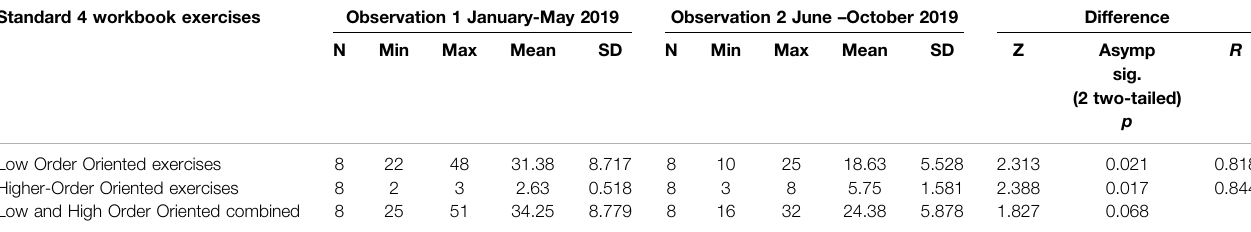
TABLE 7 | Rating results of students ’ learning exercises during pre- and post-observation as observed by the